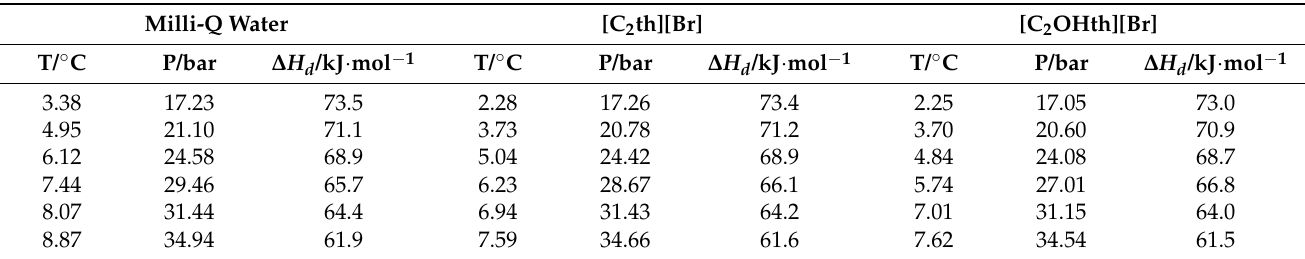
Table 1. CO 2 hydrate dissociation conditions and enthalpies ( ∆ H d ) in water and in 10 wt% aqueous solutions of ionic